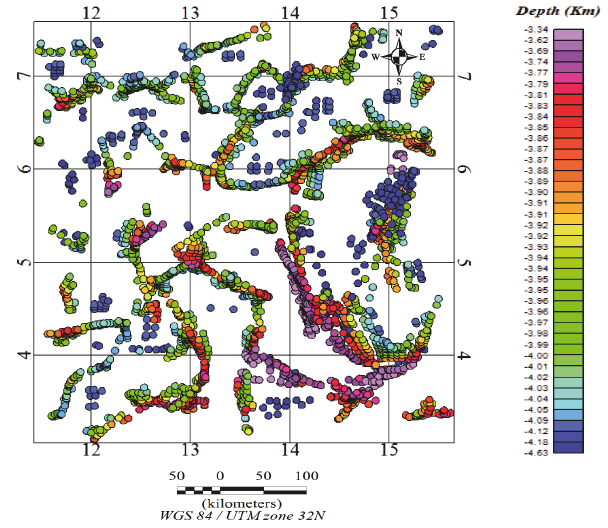
Figure 9: Euler depths map of the study area with geological boundaries obtained with structural index N = 0 , window size of 10 grid cells, and depth tolerance of 15%.